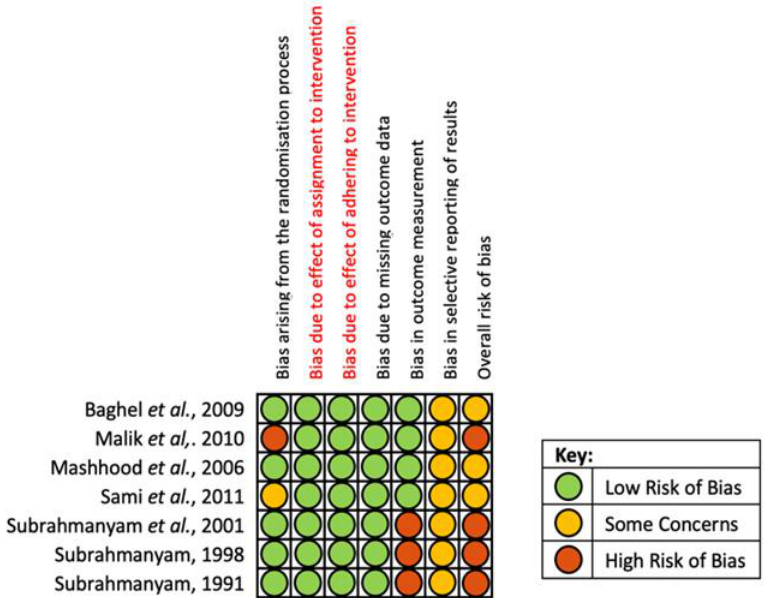
Figure 4. Risk of bias assessment summary according to the Cochrane RoB - 2 tool [24 – 30].